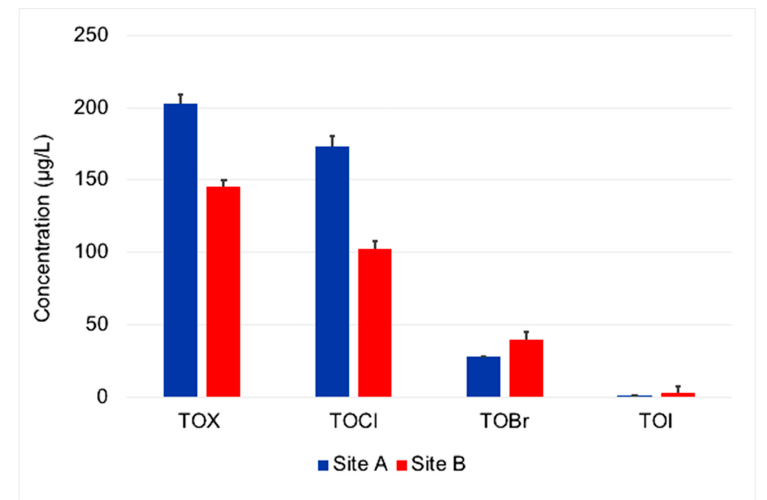
Figure 1. Comparison of total organic halogen in drinking water systems located at Site A and Site B. Legend: Three specimens were collected from each site. The error bars indicate standard deviation in the measured levels. TOX and TOCl levels were statistically different between the two sites (TOX p = 0.01; TOCl p = 0.0006).